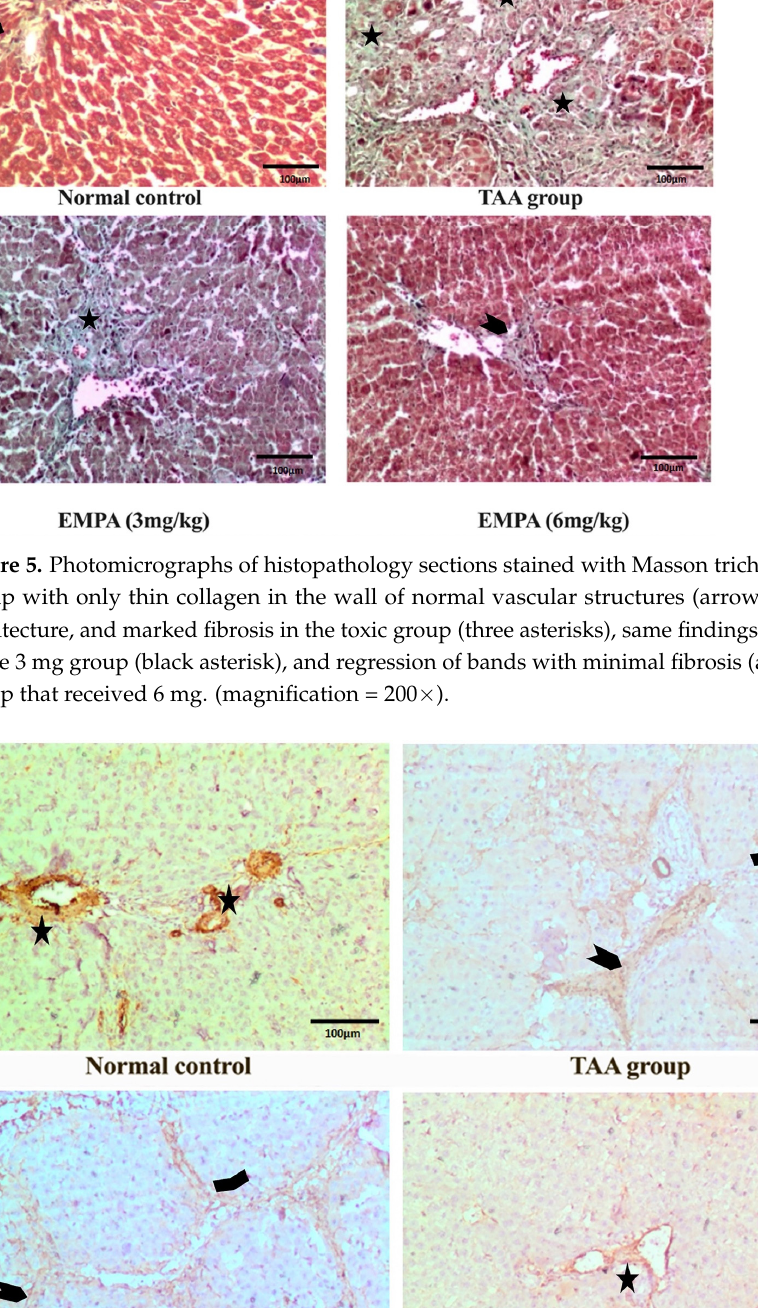
Figure 5. Photomicrographs of histopathology sections stained with Masson trichrome. The control group with only thin collagen in the wall of normal vascular structures (arrow head), disturbed architecture, and marked fibrosis in the toxic group (three asterisks), same findings as the toxic group in the 3 mg group (black asterisk), and regression of bands with minimal fibrosis (arrow head) in the group that received 6 mg. (magnification = 200×).